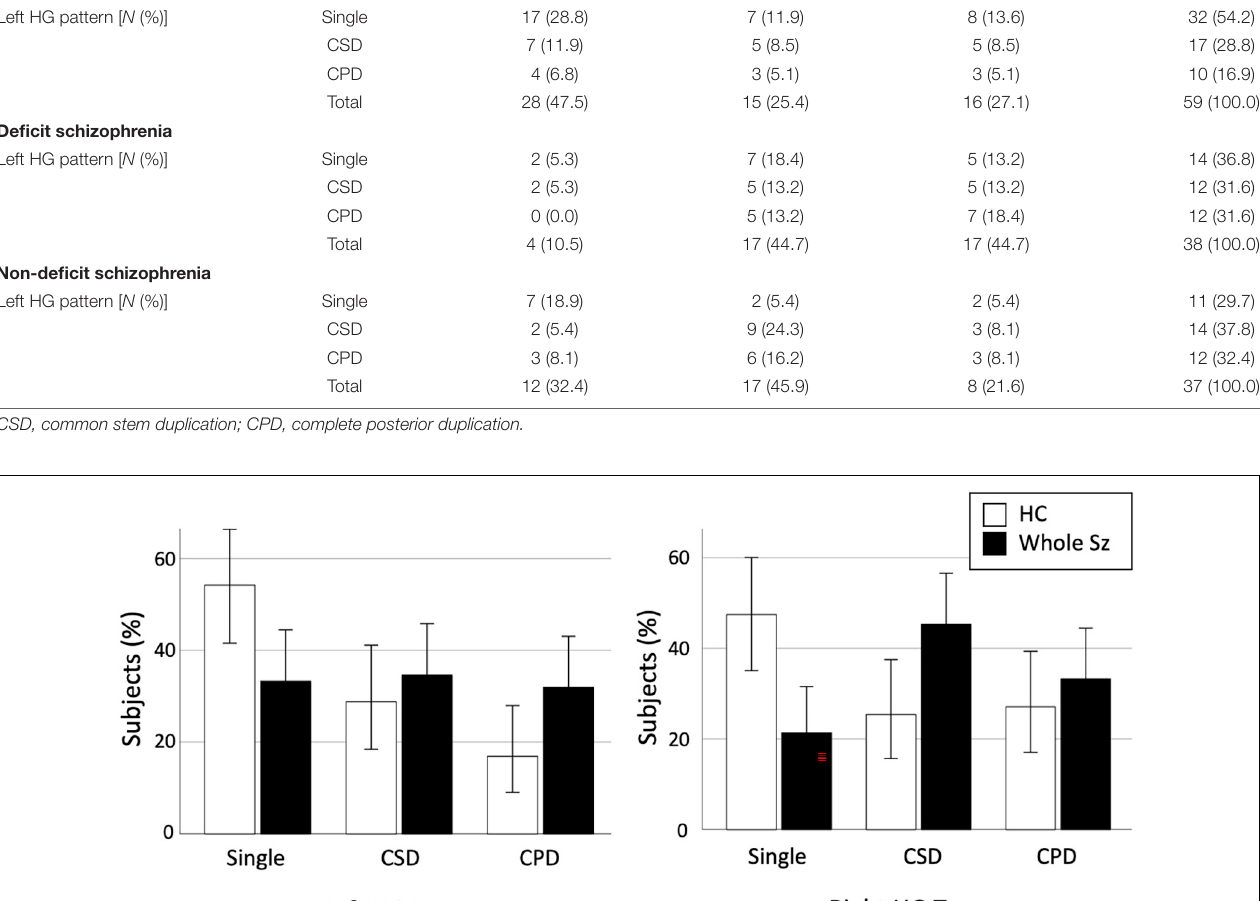
Right HG pattern [ N (%)] Single CSD CPD